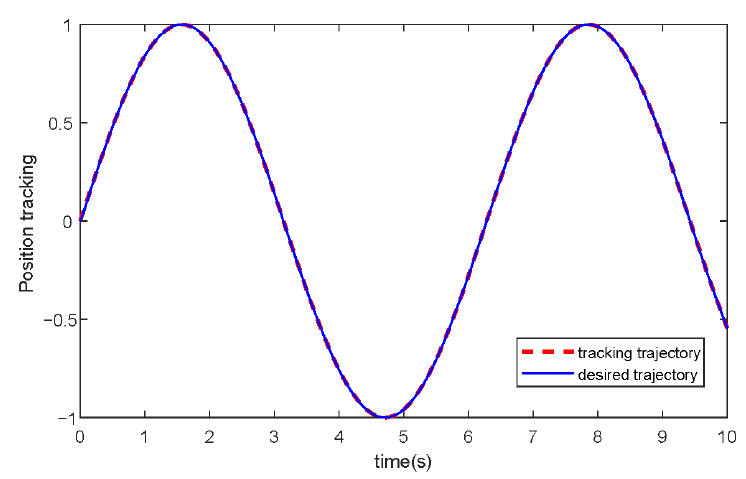
Figure 8. Position tracking curves under the second case.